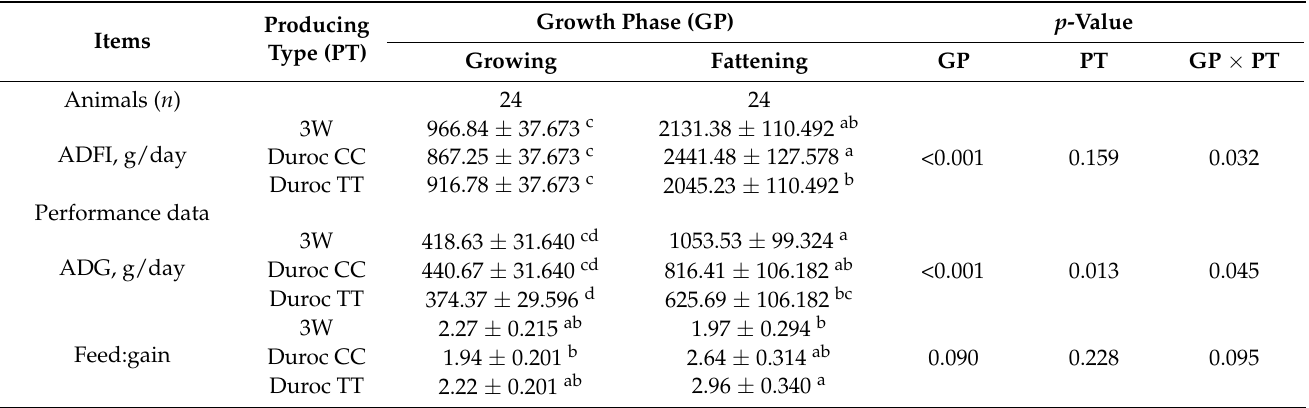
Table 2. Least square means ( ± SE) for average daily feed intake (ADFI), average daily gain (ADG), and feed:gain ratio in growing and fattening three-way (3W) crossbred pigs, and purebred Duroc pigs of TT/CC SCD genotype.